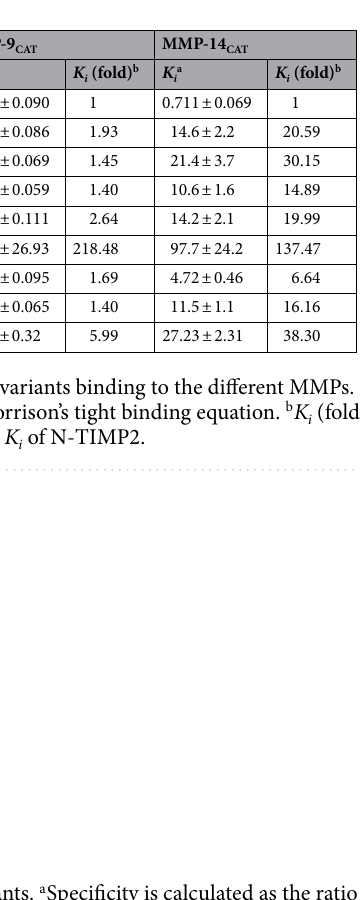
Table 2. Inhibition specificity of N-TIMP2 variants. a Specificity is calculated as the ratio between the affinity ( K i ) for MMP-14 CAT in comparison with other MMPs [ K i for MMP-14 CAT / K i for MMP-2 ACT or MMP-9 CAT ].